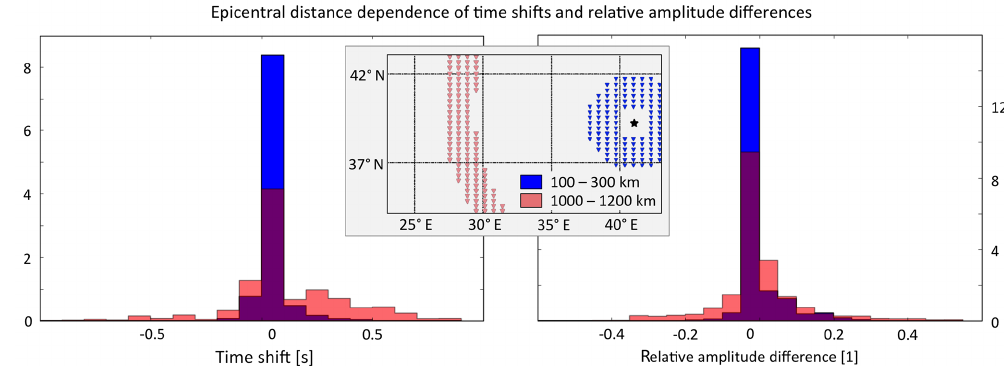
Figure 8. Normalised time shifts (left) and relative amplitude differences (right) for stations in two epicentral distance ranges: 100–300 (blue) and 1000–1200km (magenta). The source-receiver configuration is shown in the inset. The frequency range is 0 . 02–0 . 125Hz. The spread of both time shifts and relative amplitude differences increases with epicentral distance, indicating that the observed waveform differences accumulate with increasing propagation distance instead of being a purely local effect.